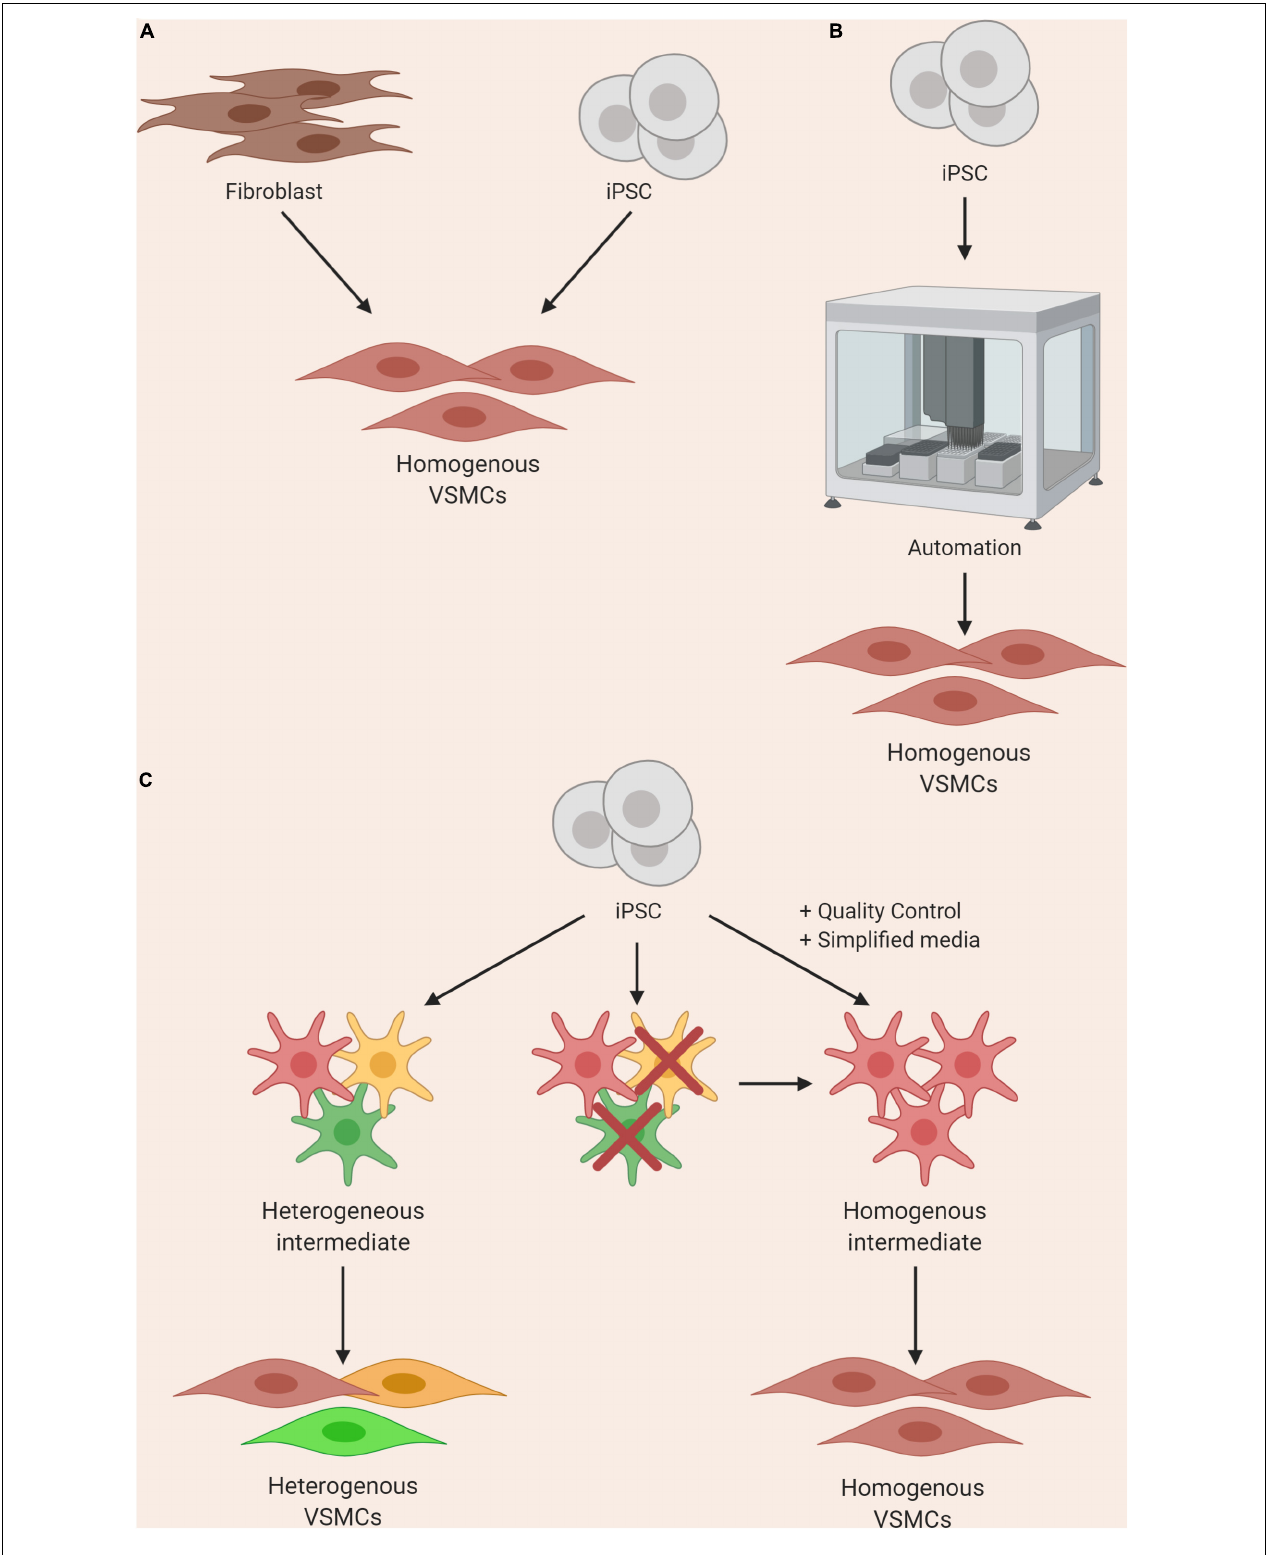
FIGURE 3 | Approaches to improving homogeneity of VSMC differentiations by using (A) direct or forward reprogramming methods, (B) automation, or (C) improved quality control and simplification of media components.